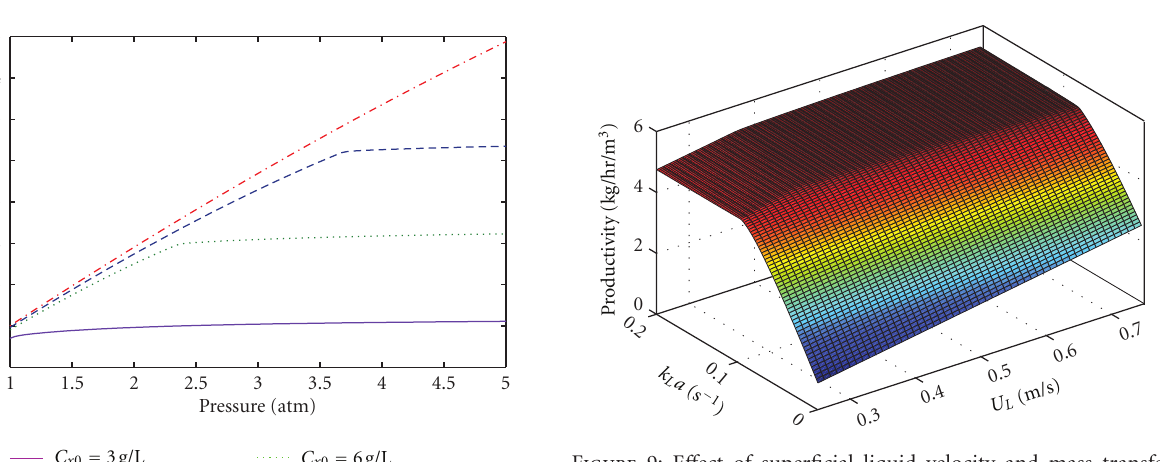
Figure 9: E ff ect of superficial liquid velocity and mass transfer coe ffi cient on the productivity of the bioreactor ( P T = 3atm, C x 0 = 15g/L, and U G ,0 = 0 . 043